Question: Express in one sentence what the figure is showing.
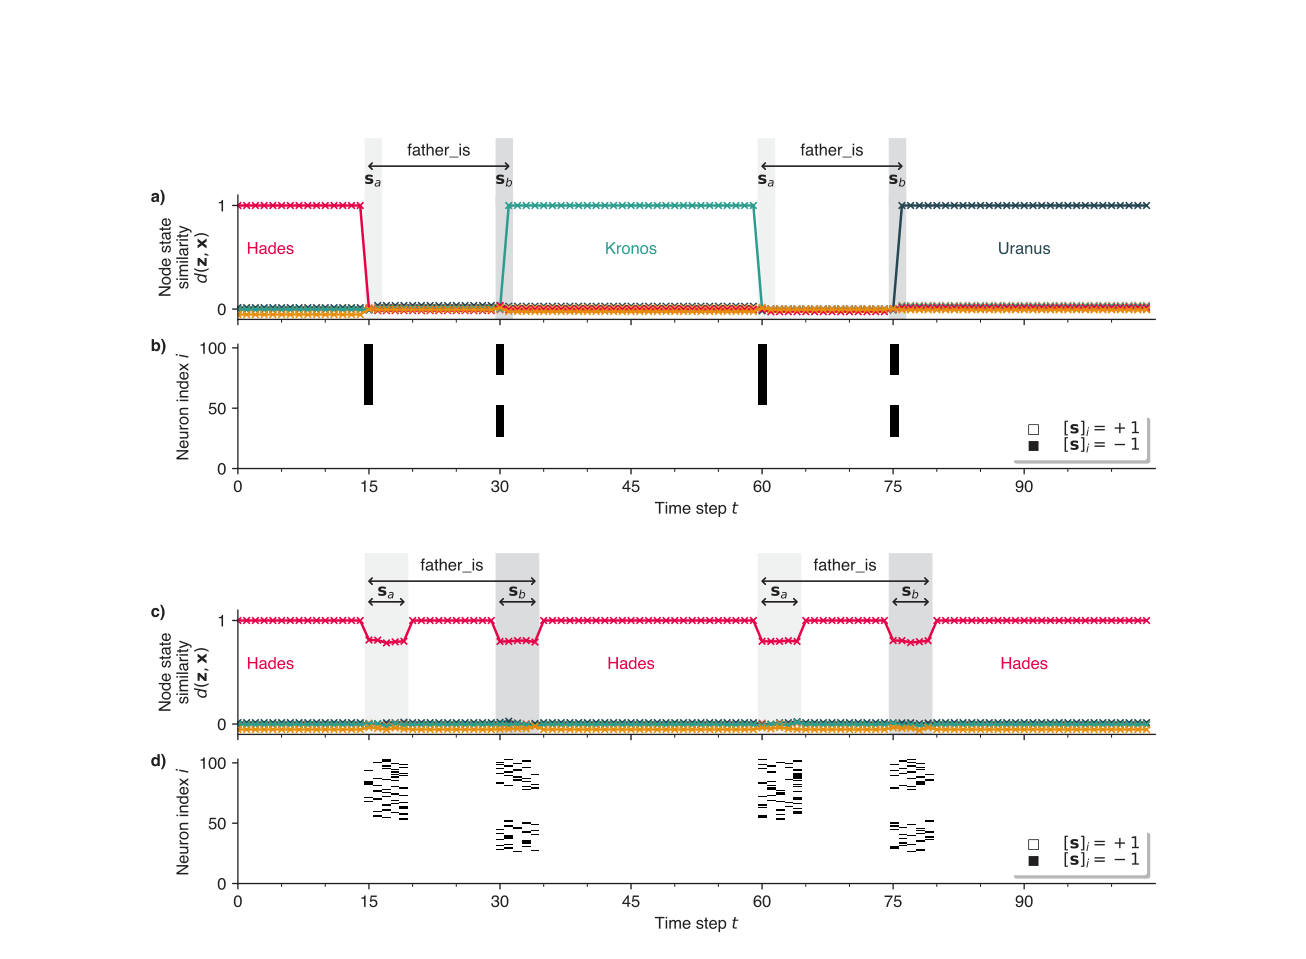
Answer: An attractor network constructed via the simpler weights construction method specified in Section VII-C, with input to the network modelled as Hadamard product binding, rather than component-wise masking. a) The similarity of the network state zt to stored node hypervectors, when the stimulus hypervector s is applied on one time step for all neurons simultaneously. b) A subset of the stimulus hypervector s at each time step in this synchronous case. c) The attractor overlaps in the asynchronous case, where the stimulus s is applied over multiple time steps randomly. d) A subset of the stimulus hypervector s at each time step in this asynchronous case. For visual clarity, the two stimulus hypervectors shown were manually chosen rather than randomly generated. In the synchronous case, the network performs the correct walk between attractor states as intended. In the asynchronous case however, the stimuli fail to effect the desired transitions, since any changes in the network sta